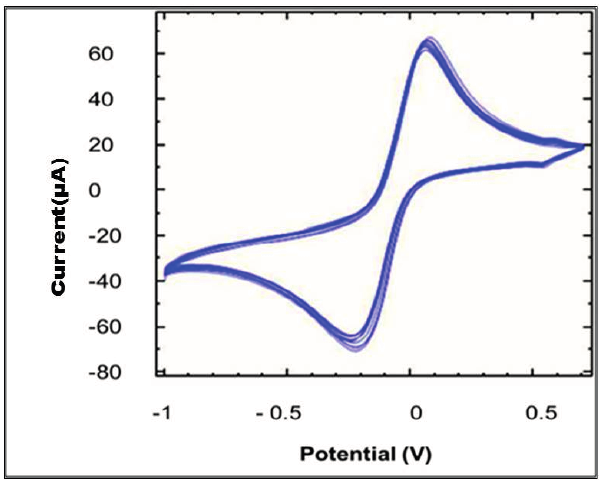
Figure 1. Cyclic voltammogram profile of the SPCEs with 10 cycles. Scanning